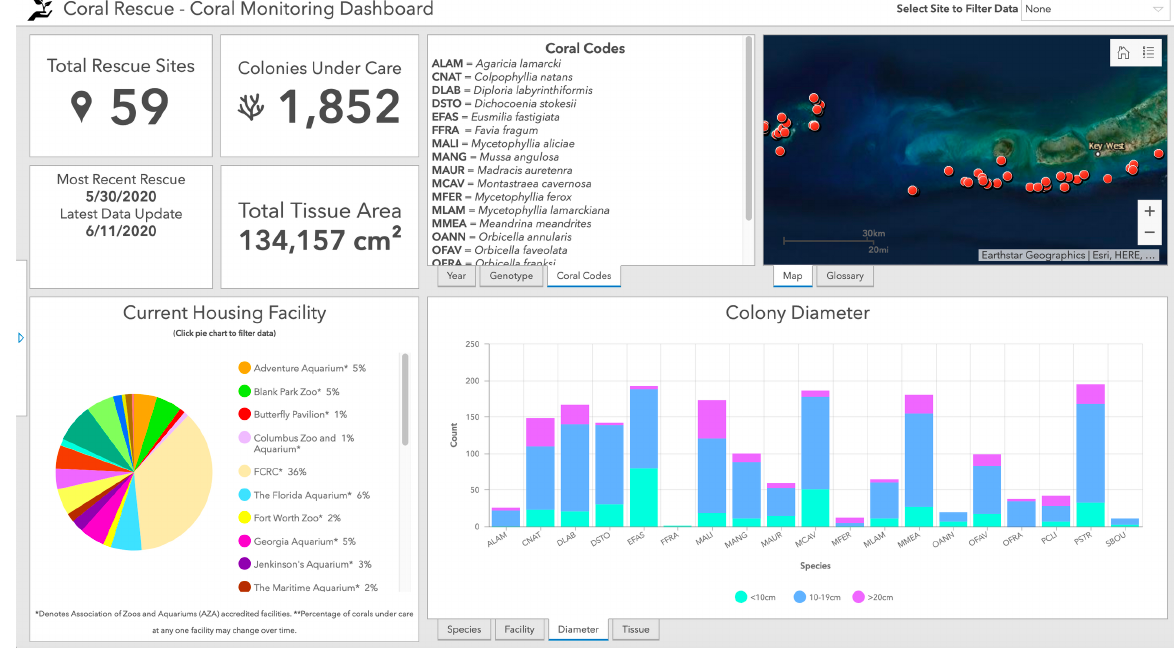
Figure 2: Coral Rescue–Coral Monitoring Dashboard. Screenshot captured August 1, 2020. Source: FWC Fish and Wildlife Research